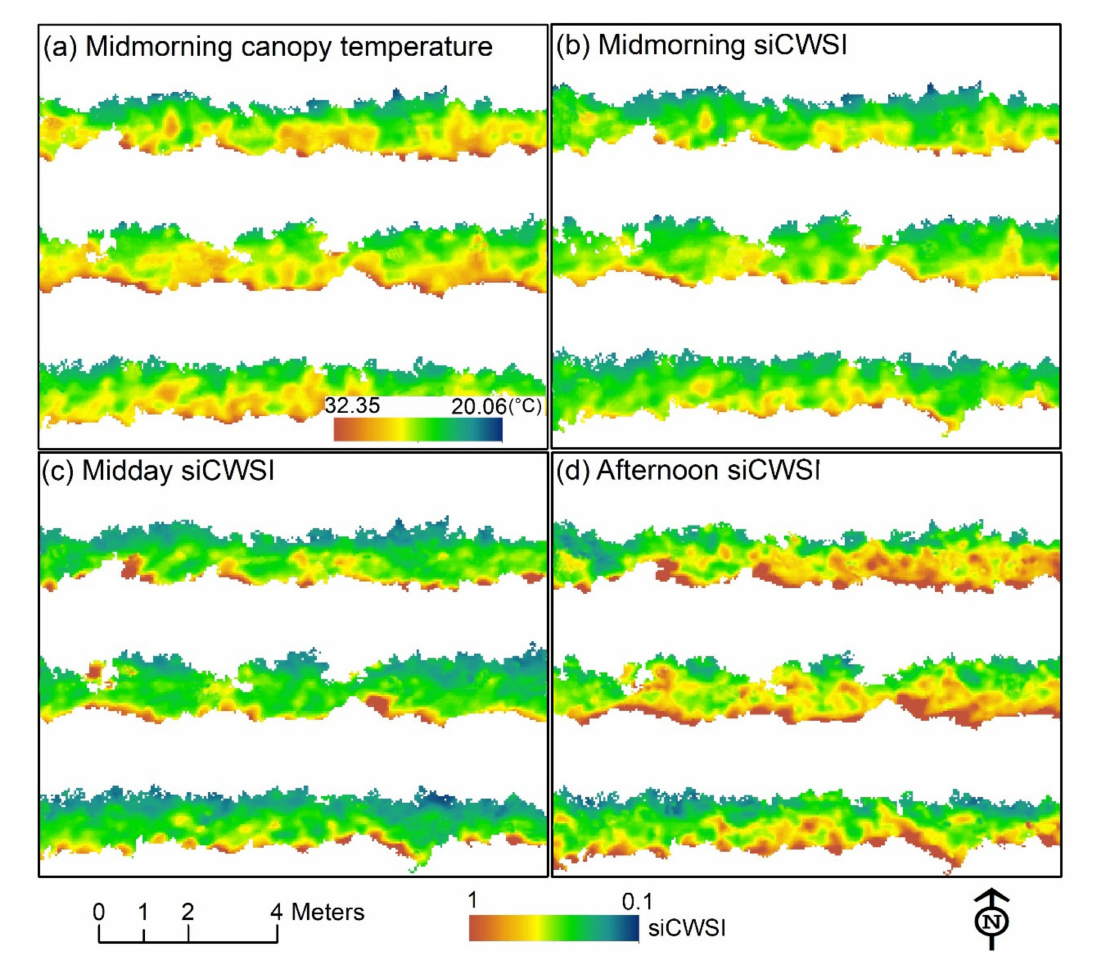
Figure 15. Diurnal siCWSI at the canopy level retrieved from the thermal images acquired on 15 September 2018. ( a ) Zoom on canopy temperature of three vine rows corresponding to three irrigation treatments, ( b – d ) zoom on vine rows showing siCWIS retrieval